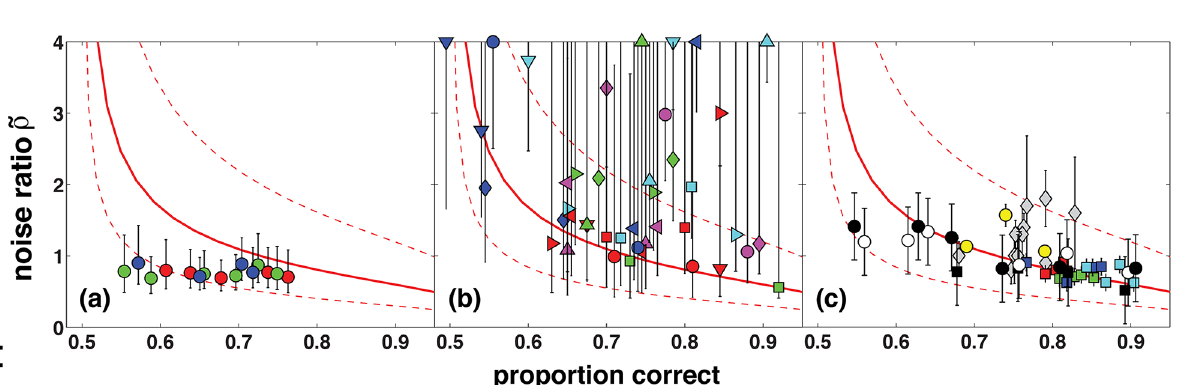
Fig 3. Results from two-pass experiments with human observers. In each panel the solid red line is a section of the lowest red line in Fig 1d, which represents the posterior probability matching model observer with no internal noise. The two dashed red lines have y-values twice as large and half as large as the solid red line. Error bars show 95% confidence intervals. (a) Experiment 1, practised observers. Each colour represents a different observer. (b) Experiment 2, unpractised observers. Each coloured symbol represents a different observer. (c) Data from Burgess and Colborne ’ s [12] Fig 2 (coloured squares) and Fig 4 (black squares, black circles, white circles), Neri ’ s [10] Table 1 (grey diamonds), and Murray et al. ’ s [17] Experiment 2 (yellow circles). For Burgess and Colborne, and for Murray et al., each data point represents a single observer. For Neri, each data point represents an average over several